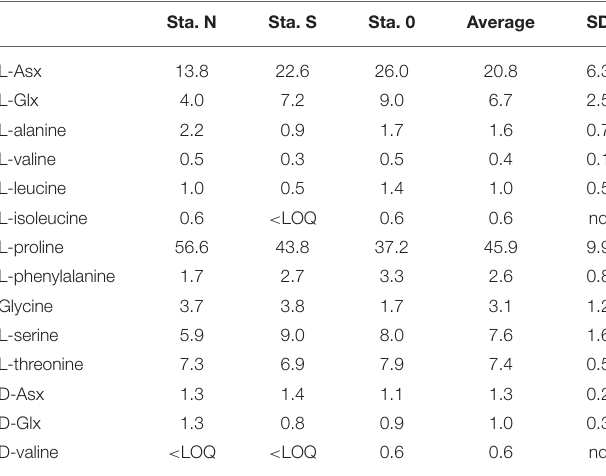
TABLE 6 | Mole% of AAs in isolated bacterial strains grown in the